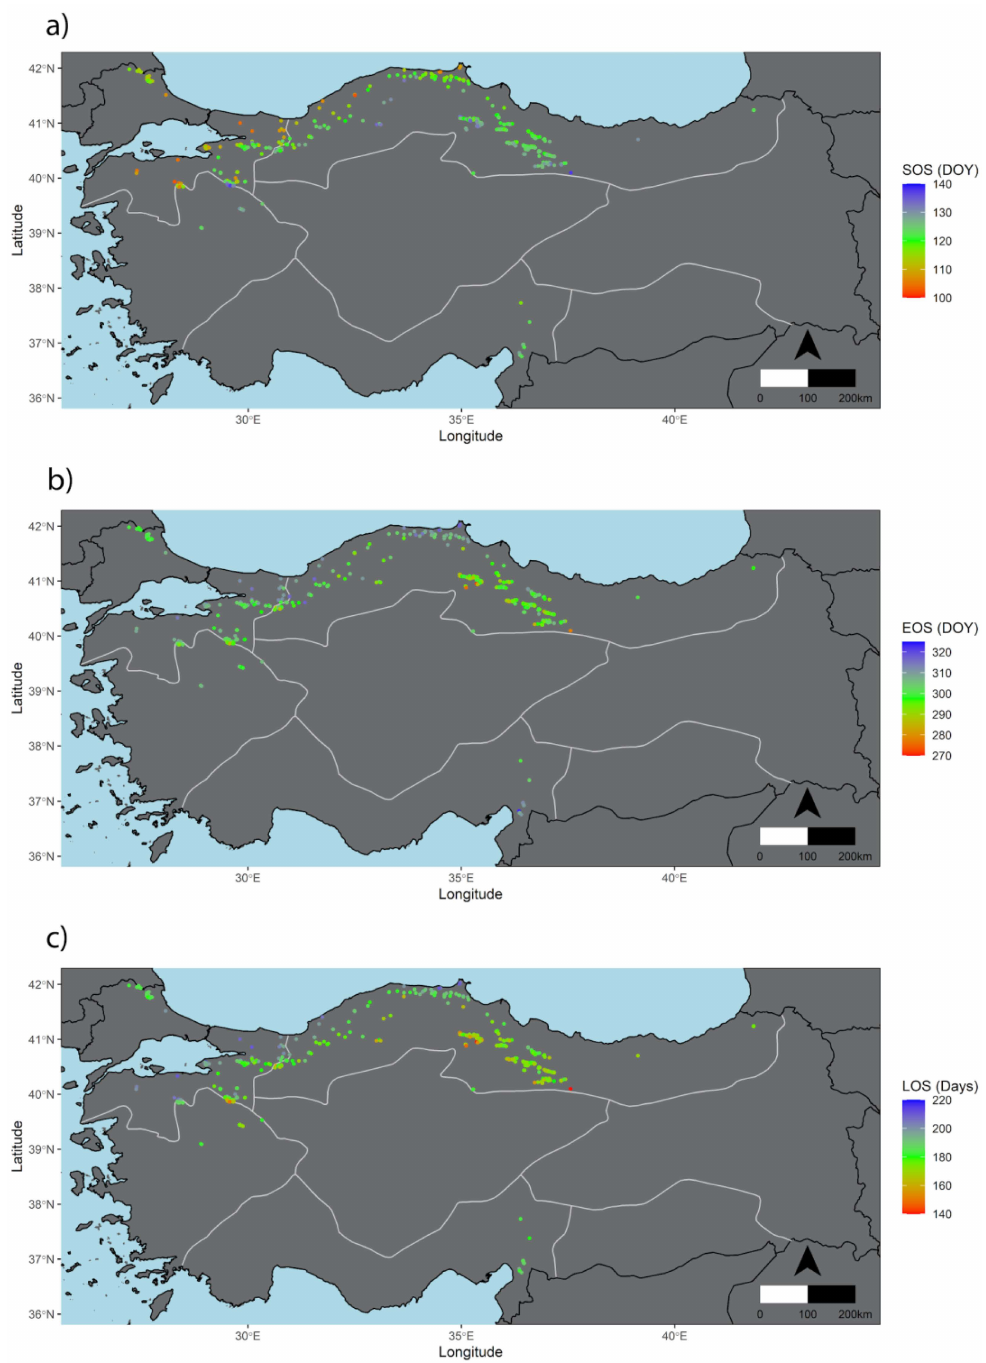
Figure 5. Distributions of multi-annual mean ( a ) SOS and ( b ) EOS dates, and ( c ) LOS over the study period